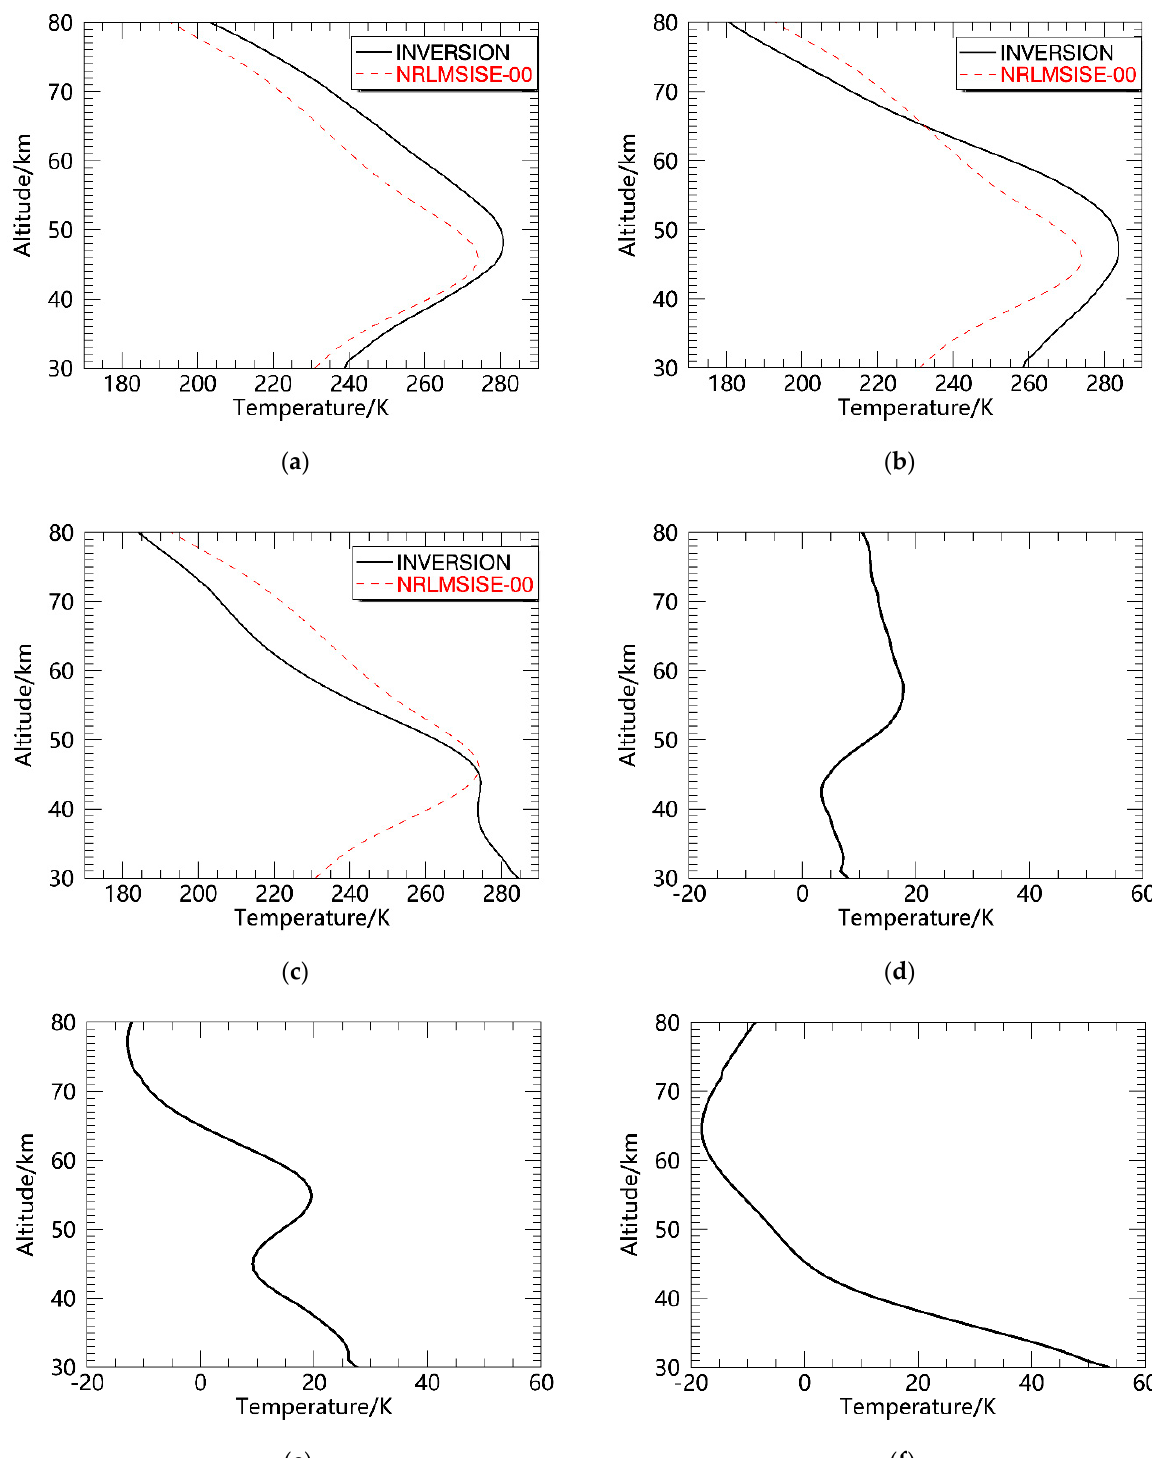
Figure 8. a–c Comparison of temperature between the inversion and NRLMSISE-00 model from 30 km to 80 km with roll angles of 10°, 20°, and 30° on the precondition that the settled observation angle is 30°; d–f Deviation in temperature between the inversion and NRLMSISE-00 model from 30 km to 80 km with roll angles of 10°, 20°, and 30° on the precondition that the settled observation angle is 30°.